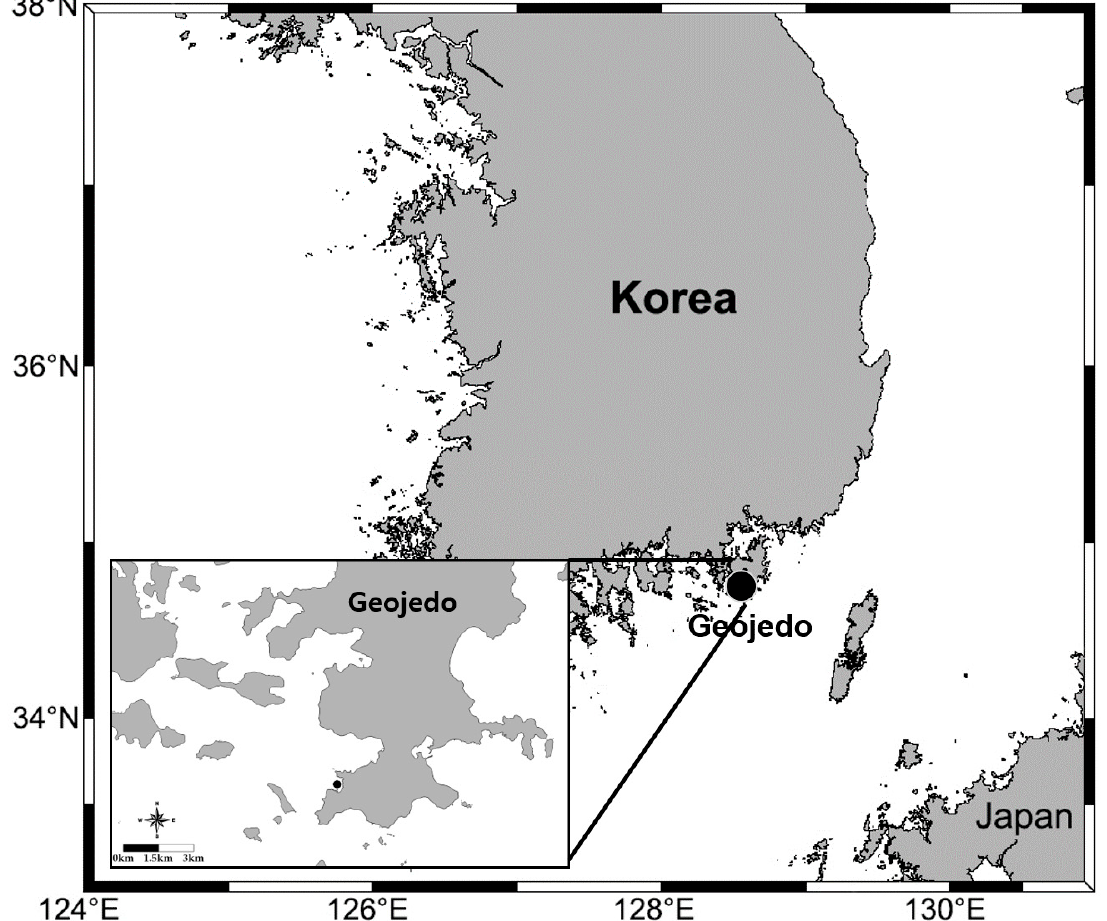
Figure 1. Map of study area showing type locality of D. geojedoensis sp.